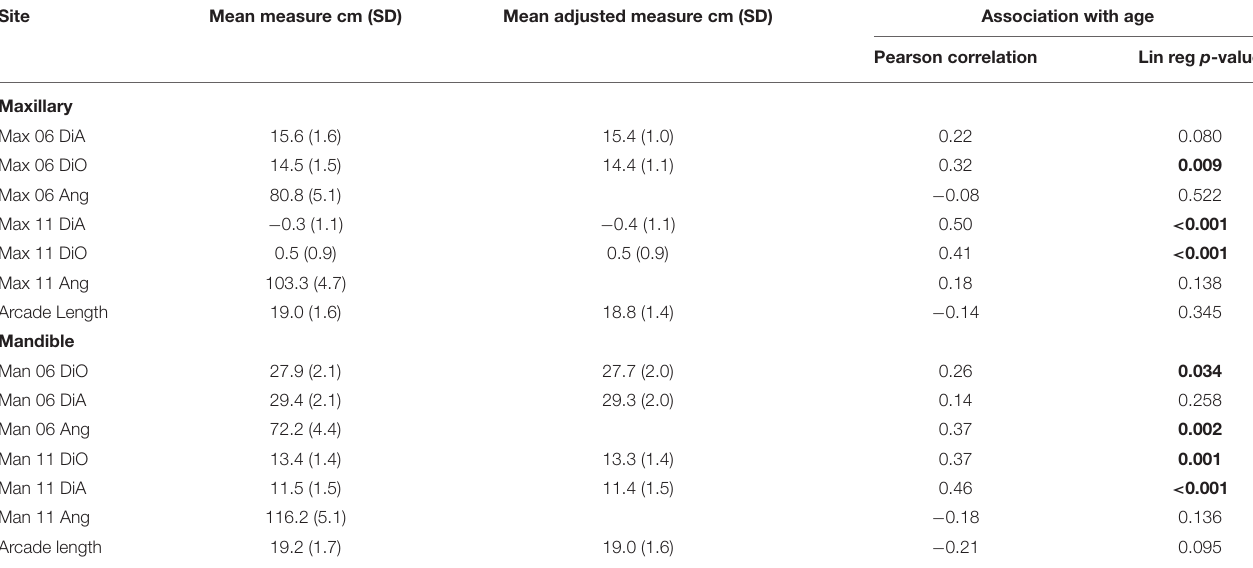
TABLE 2 | Mean measures (cm) and angles (degrees) and adjusted measures for each site from 67 horses.